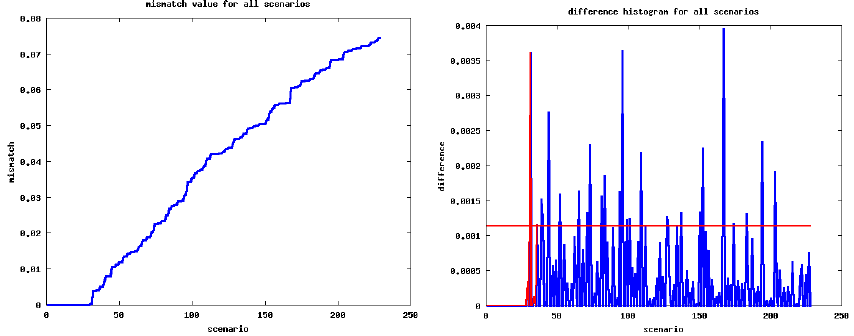
Fig. 8. Mismatch histogram for the synthetic test case with approximately 220 pre-computed scenarios (left). The difference plot (right) shows the difference of mismatch values of predecessor scenario to following scenario. Peaks show the location, where a next “plateau level” in the mismatch list is reached. The list is cut off after the second significant peak, where the horizontal line indicates the threshold value for significant .